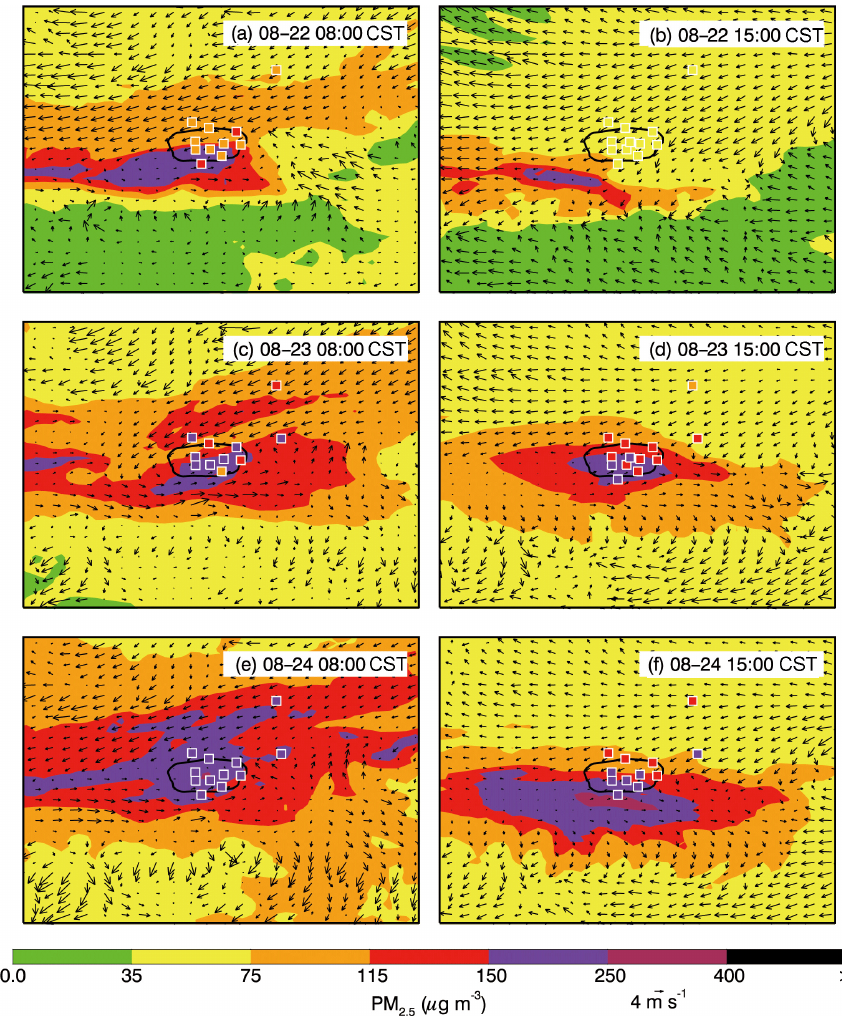
Figure 12. Pattern comparison of simulated vs. observed near-surface PM 2 . 5 concentrations at 08:00 and 15:00CST from 22 to 24 Au- gust 2013. Colored squares: PM 2 . 5 observations; color contour: PM 2 . 5 simulations; black arrows: simulated surface winds.